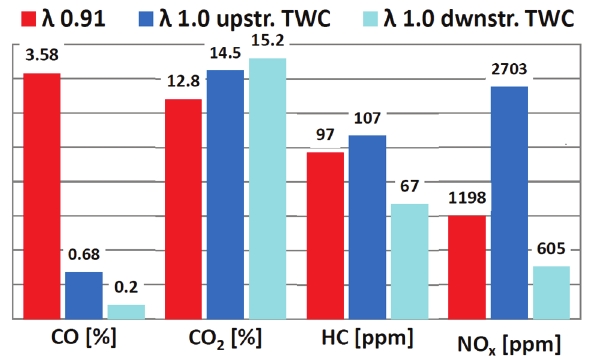
Fig. 11. Comparison of CO, CO 2 , HC and NO x concentrations in exhaust of the RE engine working with factory settings ( λ 0.91), as well as with AFR modification ( λ 1.0)